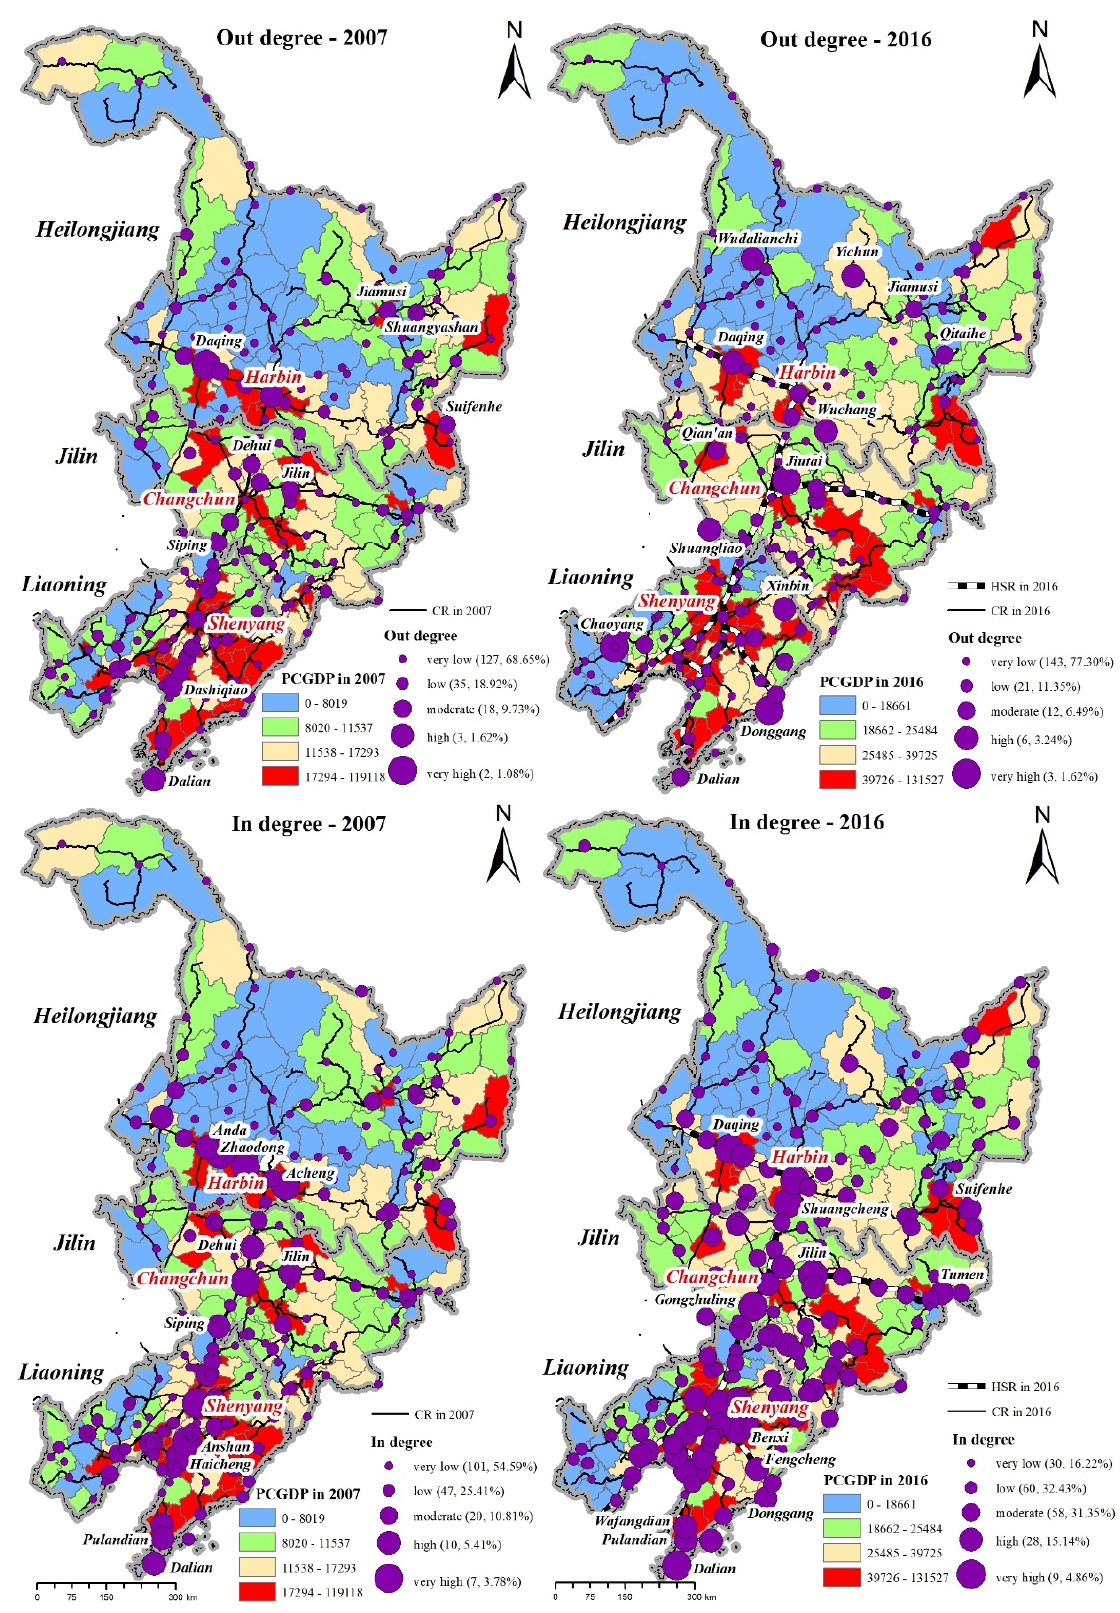
Figure 4. Nodal centrality of each city in railway networks before and after HSR (the left column represents nodal centrality of CR railway networks in 2007; the right column denotes nodal centrality of CR and HSR railways networks in